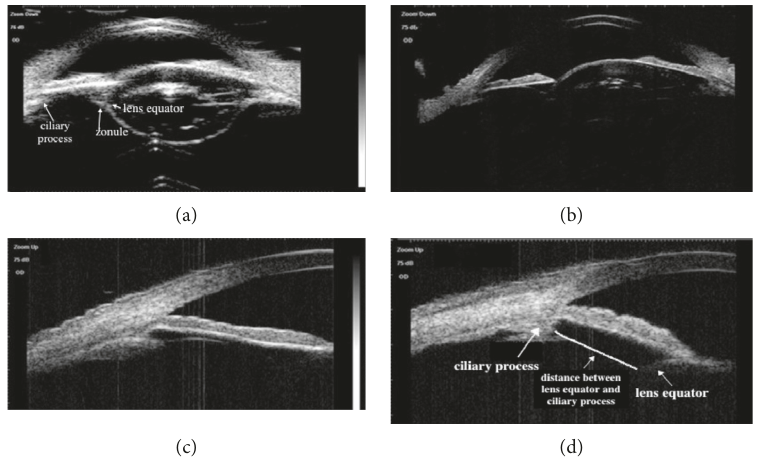
Figure 2: Subluxated lenses with age-related cataract images obtained in the same patient with 25 and 50MHz UBM. (a) A 25MHz UBM axial section image shows that the anterior chamber geometry is distorted, the distance between the ciliary process and lens equator is increased on the subluxated side, and the side of the lens equator with increased distance is more curved than the other side; the opacity of the lens, ciliary process, lens zonule, and lens equator are shown clearly (arrows); (b) a 50 MHz UBM axial section image shows only that the anterior chamber geometry is distorted; the distance of the subluxated side and other lesion features of the lens are not shown clearly; (c, d) the 50MHz UBM longitudinal section images show the difference in the distance between the ciliary process and lens equator. The distance between the ciliary process and lens equator in (d) is longer than that in